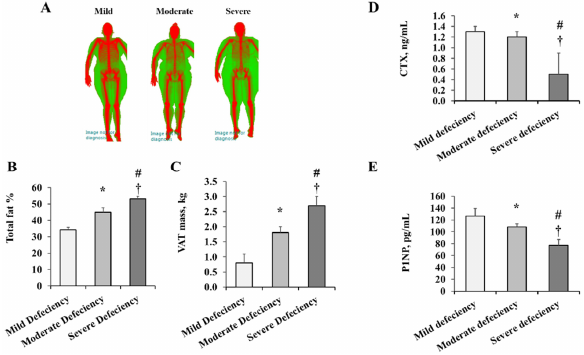
Figure 1. Fat percentage and bone turnover enzymes across VD deficiency categories. ( A ) Repre- sentative images of DEXA-measured body composition. Graphical representations of total fat % ( B ) and VAT mass ( C ) across VD deficiency groups. Serum levels of CTX ( D ) and P1NP ( E ) measured by ELISA assays. Results are represented as means ± standard error (SE). A significant p -value is denoted by * for the comparison between the mild and moderate deficiency groups, # for the comparison between the mild and severe deficiency groups, and † for the comparison between moderate and severe deficiency groups. Table 2. Cardiometabolic health